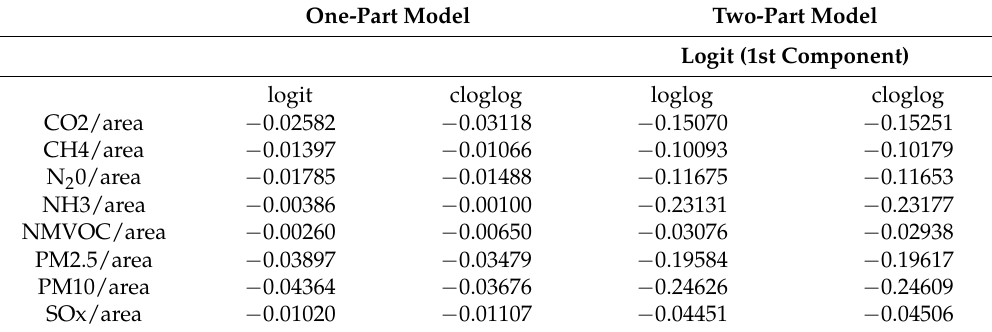
Table 6. Sample average of partial effects (APE): 2008–2018